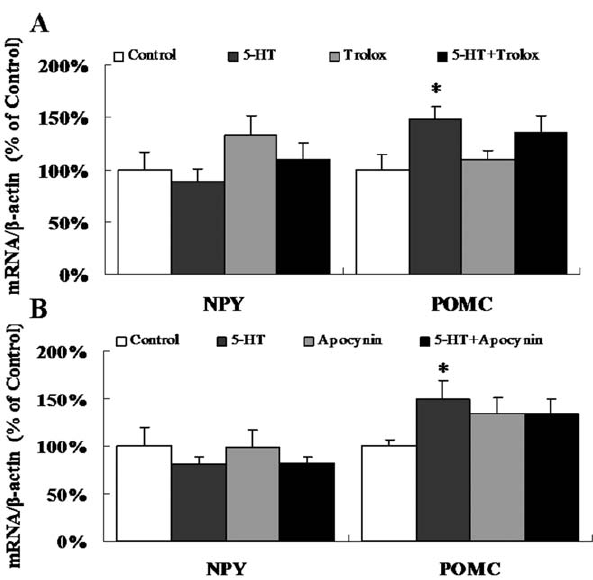
Figure 5. 5-HT-induced NPY and POMC mRNA expression. Real- time quantitative PCR was used to examine the mRNA expression of NPY and POMC. (A) ICV co-injection with 5-HT and Trolox. n=11–12 per group. (B) ICV co-injection with 5-HT and Apocynin. n=8–9 per group. Data are expressed as the means 6 SEM. *, 0.01 , p , 0.05, vs. the